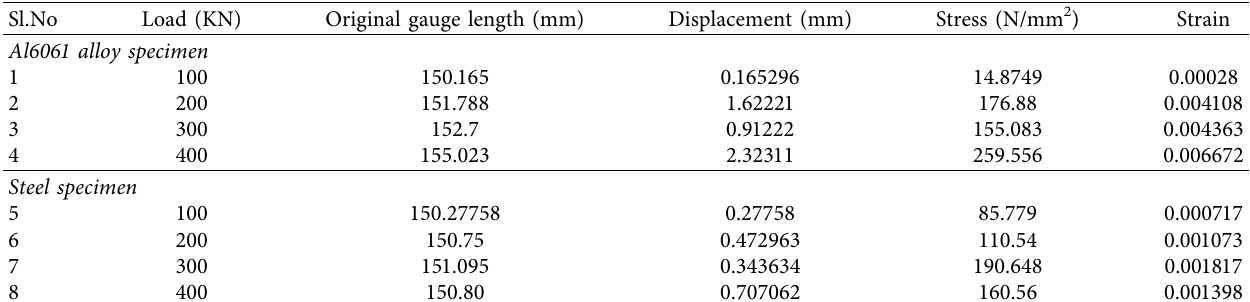
Figure 5: (a) Differentiation levels of elongation on specimens. (b), (c) Fracture curvature of steel and Al6061 specimen. Table 4: Simulations results of Al6061 and steel specimen for the different tensile